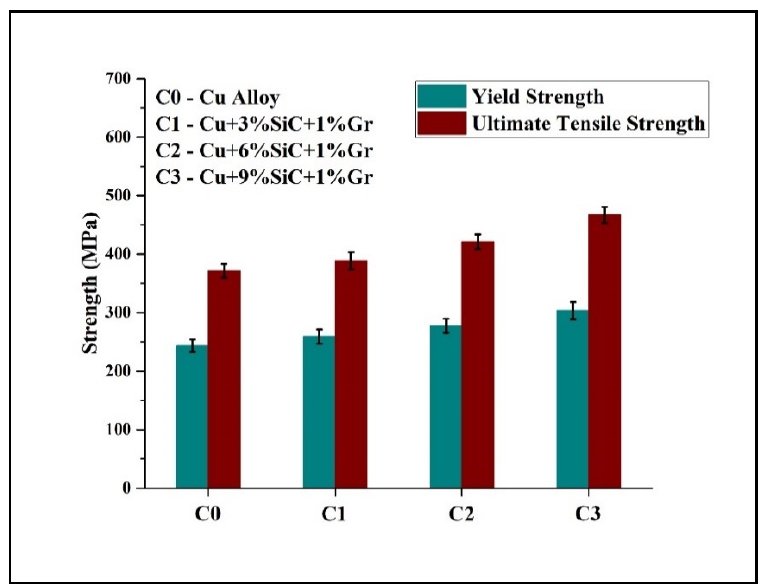
Figure 13. Variation of yield strength and ultimate tensile strength of Cu alloy and Cu-(3, 6, 9) wt.% SiC-Gr hybrid composites.